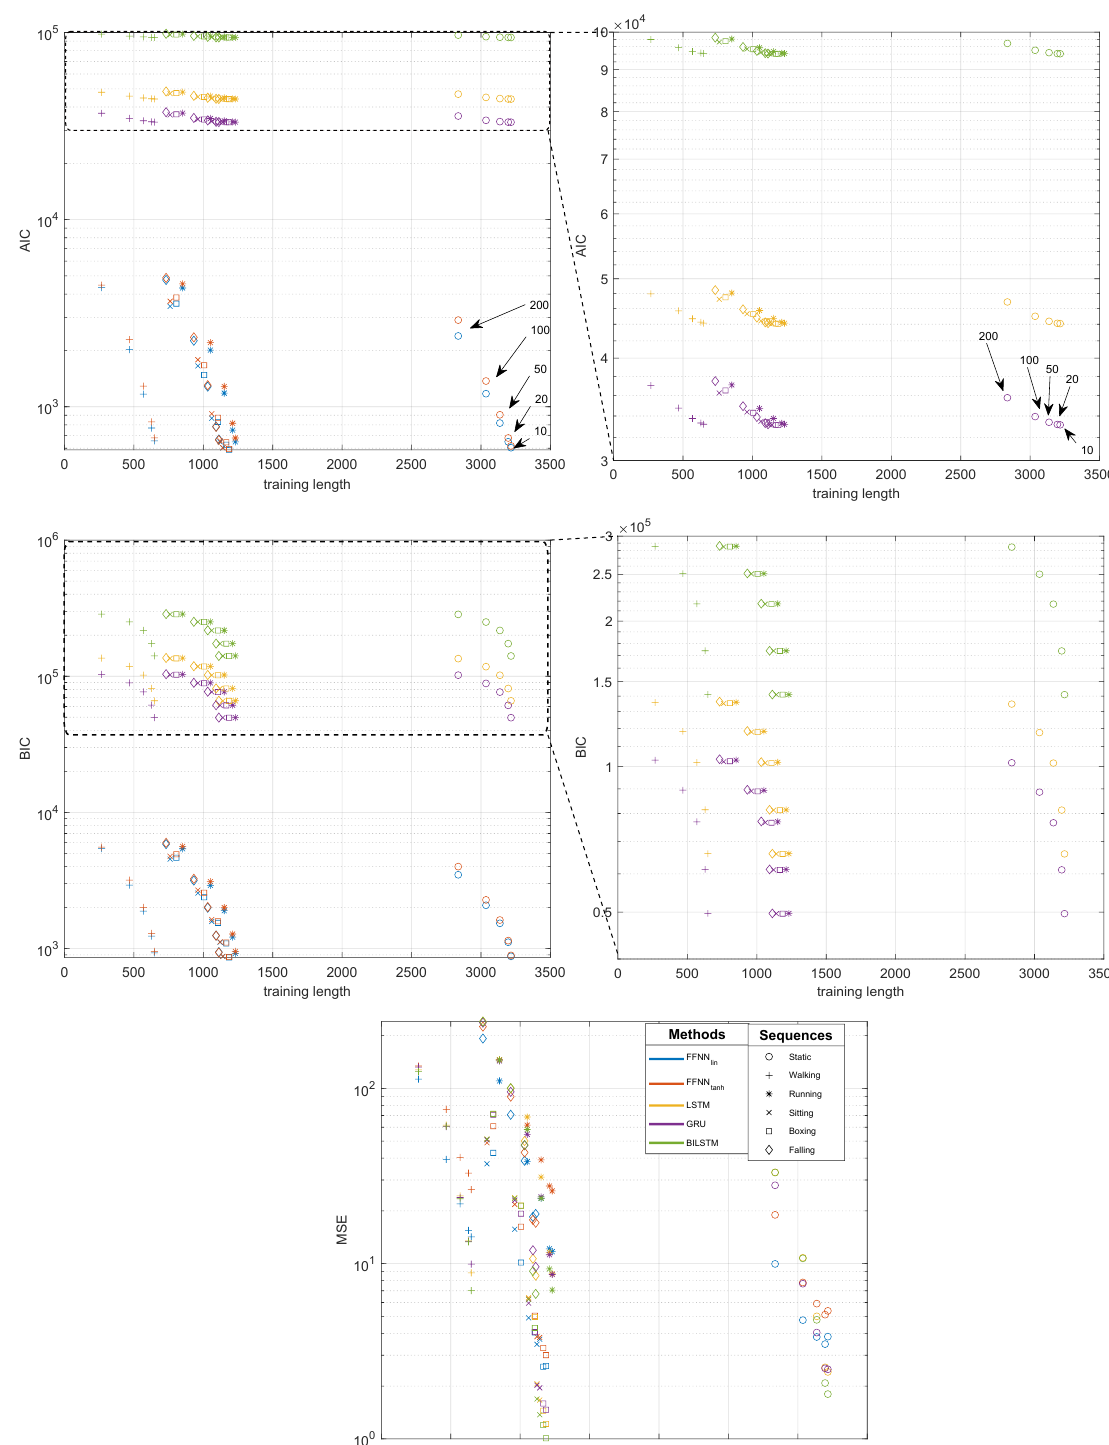
Figure 9. Influence of training sequence length on the quality of obtained results for NN methods: Akaike Information Criterion (AIC), Bayesian Information Criterion (BIC) and